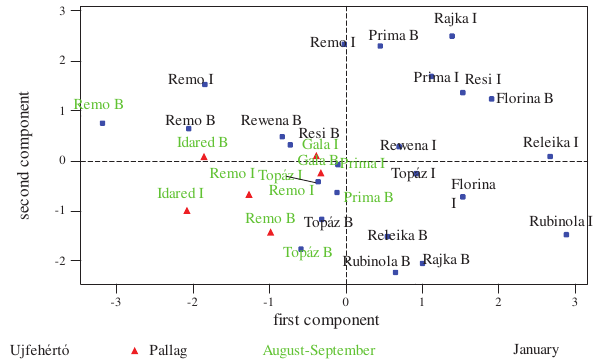
Figure 2. Principal component analysis, score plot of apple